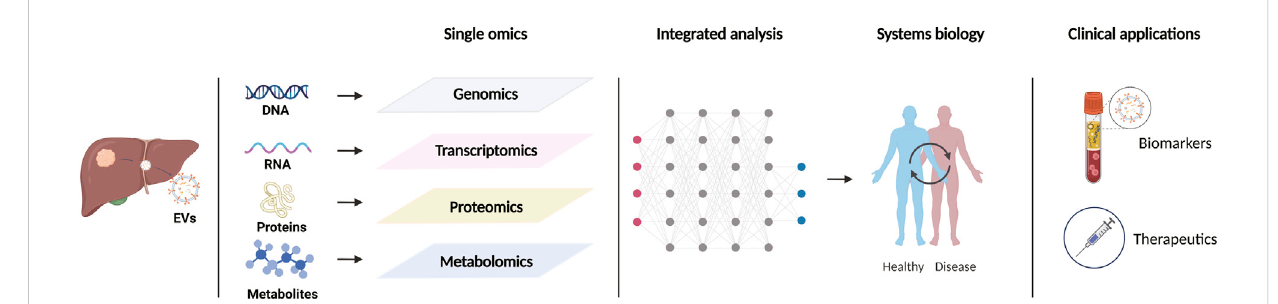
FIGURE 1 Schematic representation of multi-omics approaches to extracellular vesicles in the study of hepatic precancerous lesions and hepatocellular carcinoma. Created with